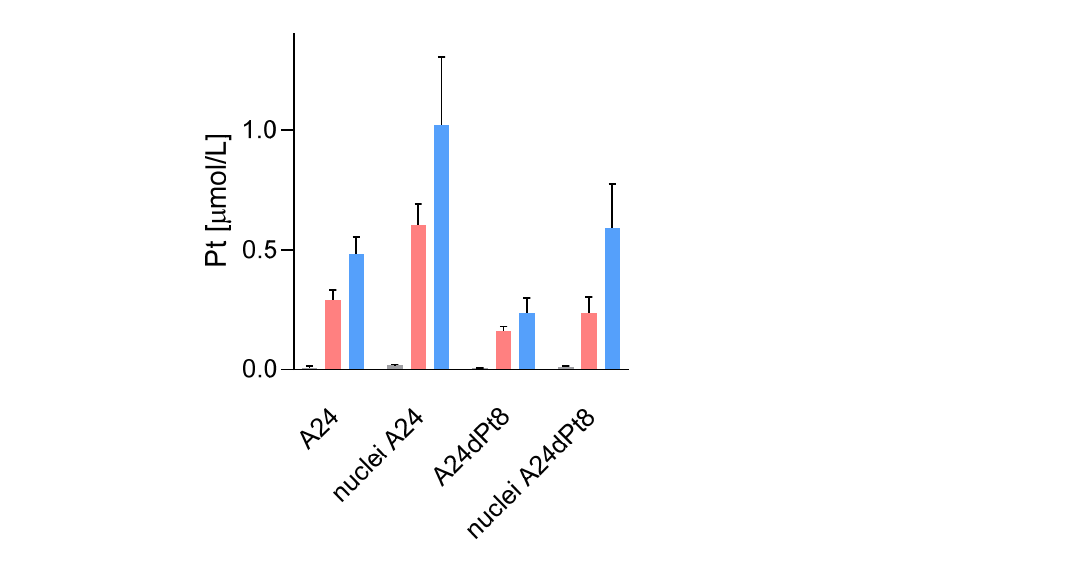
Figure 7. Nuclear and cellular cisPt concentration after incubation of A24 and A24dPt8 cells for ▐ 0, ▐ 8, and ▐ 16 h with 30 µM cisPt.